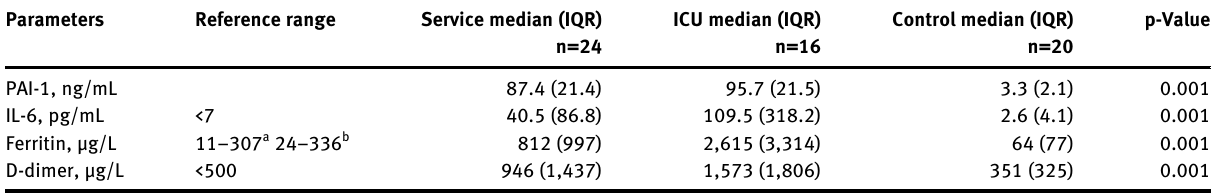
Table  : Mean values of the independent groups according to hospitalization unit and values of healthy control, for male a and female b . Parameters